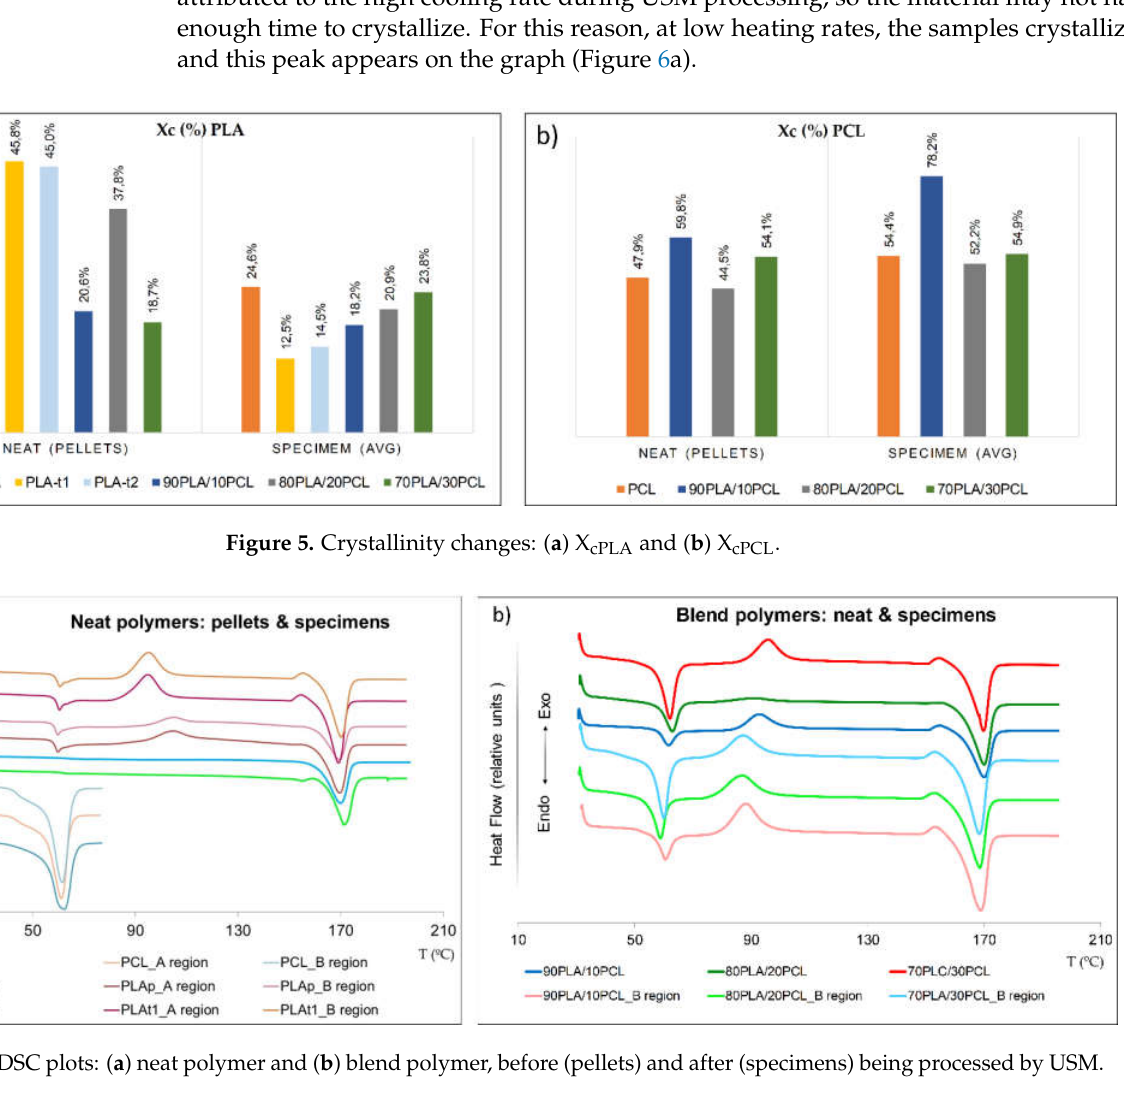
Figure 6. DSC plots: ( a ) neat polymer and ( b ) blend polymer, before (pellets) and after (specimens) being processed by USM.